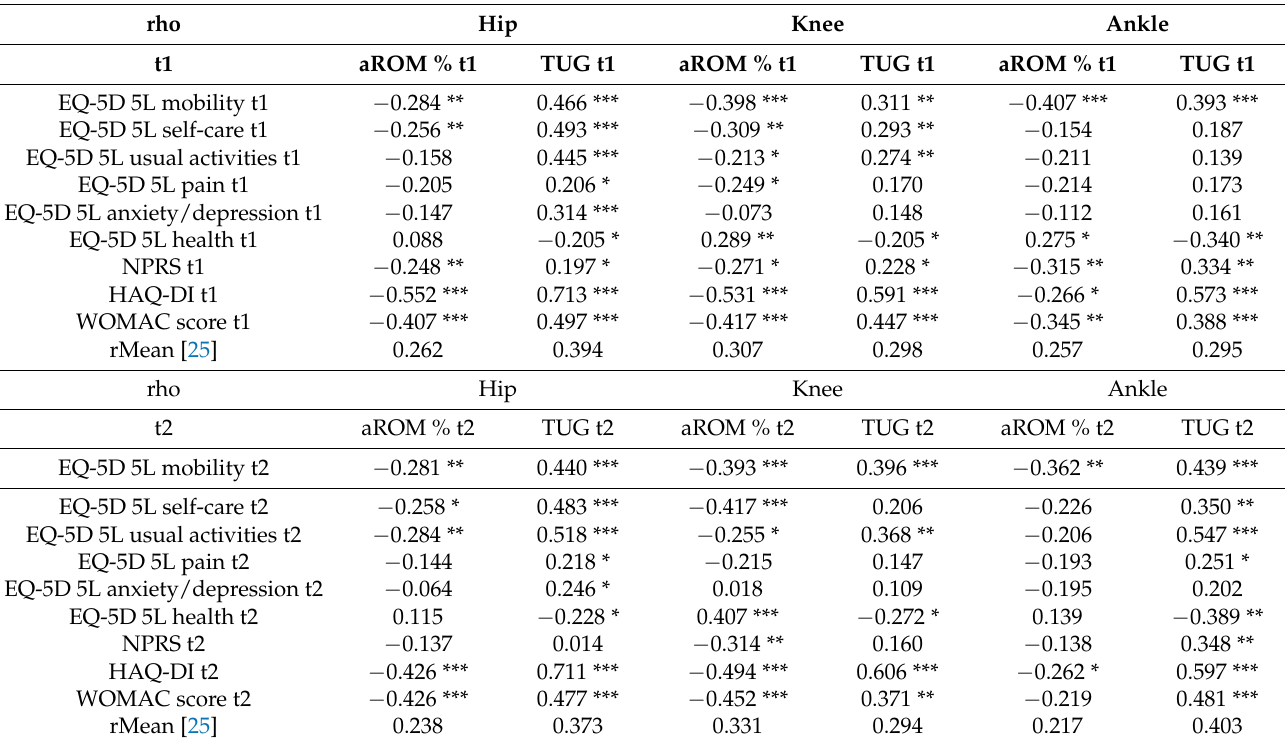
Table 3. Spearman’s rank correlation coefficients between CROMs and PROMs at baseline (t1) and after intervention